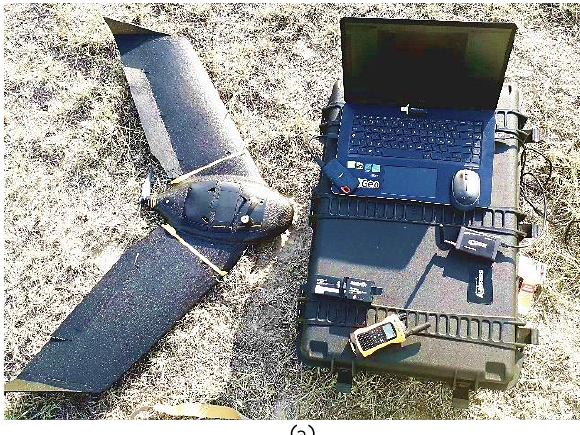
Figure 1. The acquisition phase in the fieldwork at Hierapolis